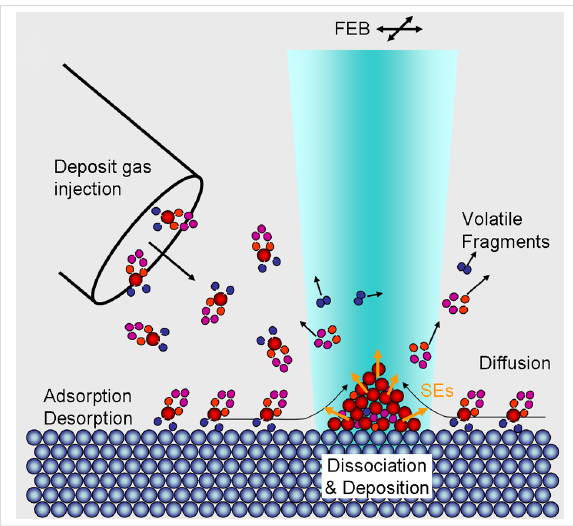
Figure 1: Schematic representation of the FEBID process (repro- duced with permission from [2], Copyright (2008) American Vacuum Society): Precursor molecules are supplied through a gas injection system, shown on the left side, and are physisorbed on the surface in dynamic equilibrium with the gas feed. Ideally, the precursor mole- cules decompose under the electron beam (shown with turquoise shading) to leave a well-defined deposit on the surface, while volatile fragments are pumped away. Diffusion of the physisorbed molecules and the generation of secondary electrons (SEs) are also indicated with black and orange arrows,